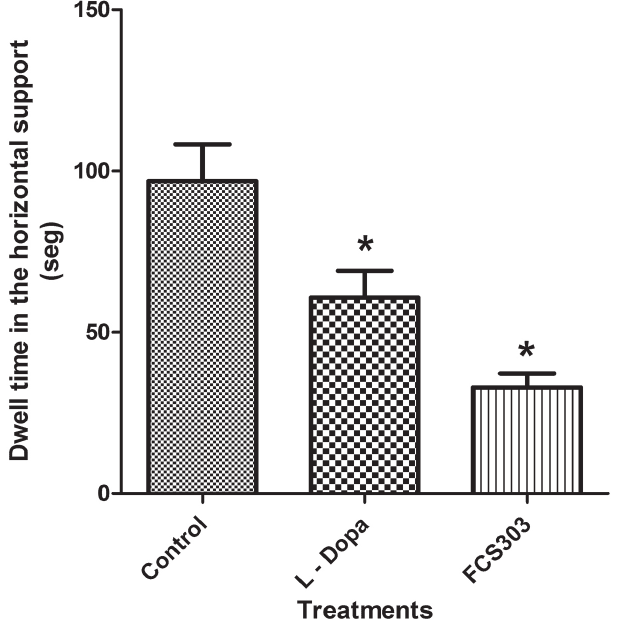
FIGURE 5 - Effect of administration of FCS303 (100 mg/kg), control (vehicle 0.1 mL/10 g body weight), or levodopa/ carbidopa (400/40 mg/kg) on catalepsy induced by haloperidol (3 mg/kg). Catalepsy in mice was assessed using the horizontal bar test 60 min after administration of treatments. n = 8. *p < 0.05 compared to the control group.